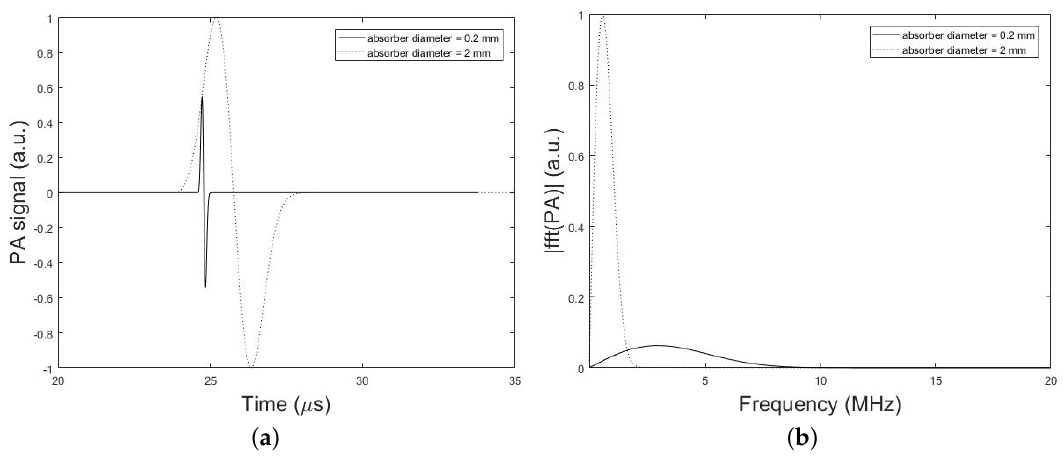
Figure 8. Simulation results. ( a ) PA signals simulated by our simulation method in the absence of the skull tissue for two different diameters of spherical absorber 2 mm (dotted line) and 0.2 mm (solid line). The setup in Figure 2 with the parameters, h = 0 mm (i.e., without skull), d = 2.7 cm, k = 10 mm, r 0 = 1 mm or 0.1 mm, r d = 0.025 inch, and T = 5 cm is used. ( b ) Corresponding normalized magnitude of the frequency spectrum of the simulated PA